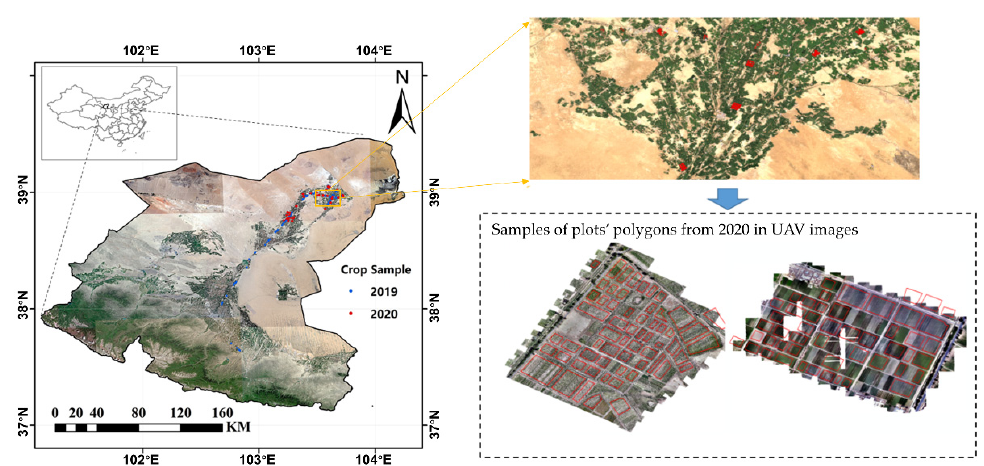
Figure 1. Study area and locations of ground truth samples.